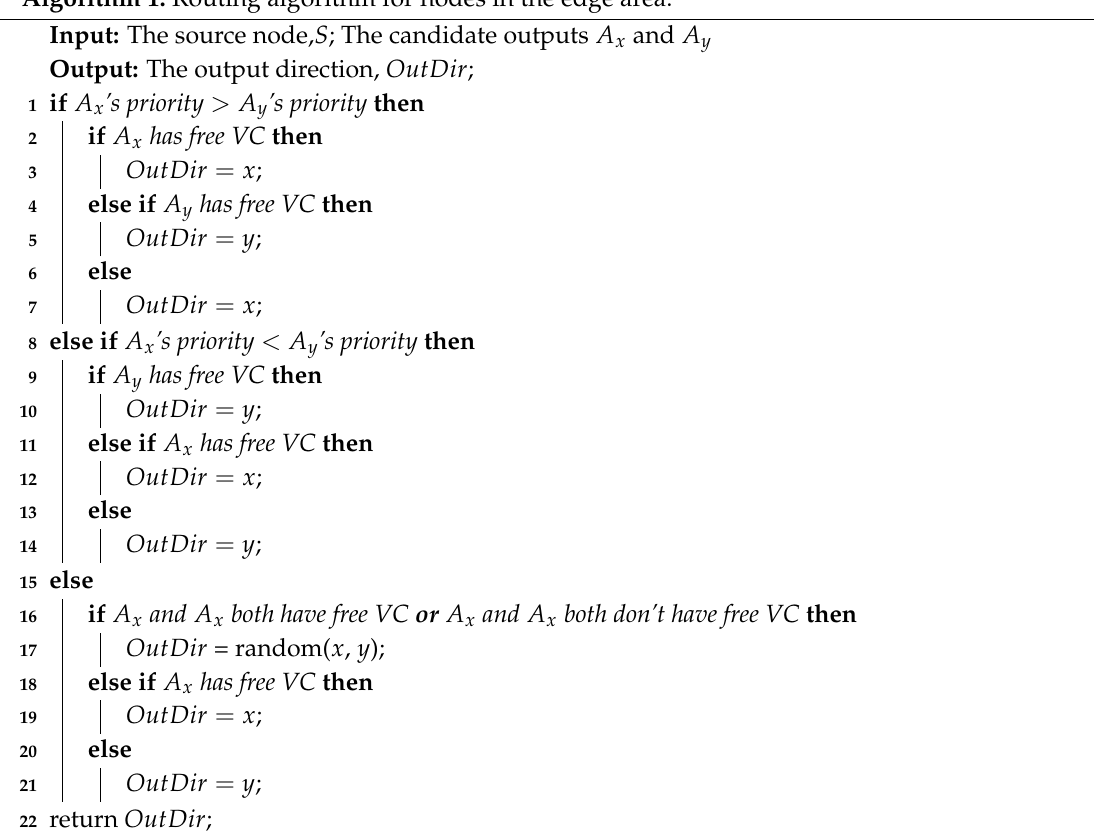
Algorithm 1: Routing algorithm for nodes in the edge